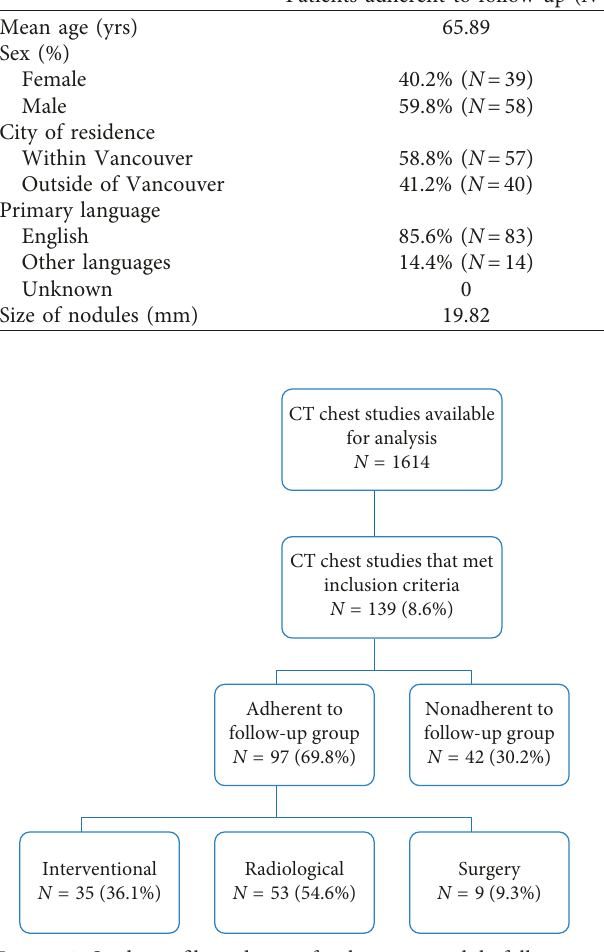
Figure 1: Study profile and rate of pulmonary nodule follow-up. Interventional follow-up refers to surgical and/or transbronchial biopsy or cytology from bronchoscopy. Radiological follow-up refers to a repeat CTchest imaging indicated for nodule assessment after an interval time. Several patients underwent surgical resection of the pulmonary nodule(s).